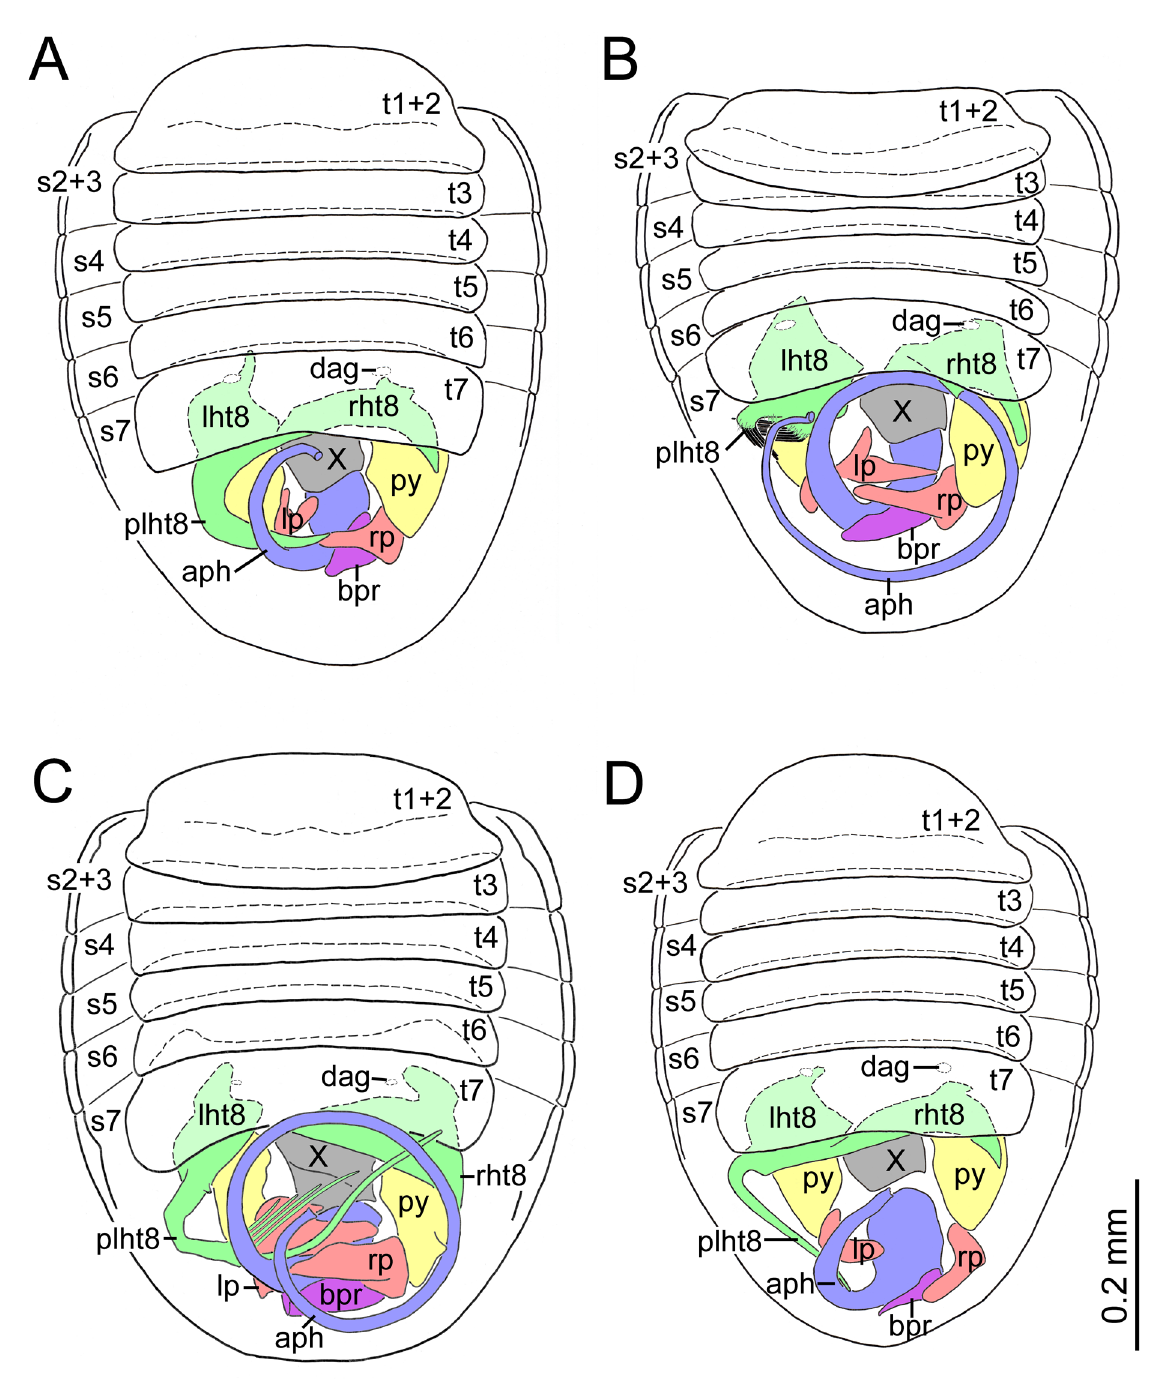
Fig. 29. Pregenital abdomen and genitalia of Kokeshia spp., dorsal views. A . K. drepanoides sp. nov., paratype, ♂ (SYSBM). B . K. hilli sp. nov., paratype, ♂ (SYSBM). C . K. hsiaoi Ren & Zheng, 1992, ♂ (SYSBM). D . K. pengae sp. nov., paratype, ♂ (SYSBM). Abbreviations: see Material and